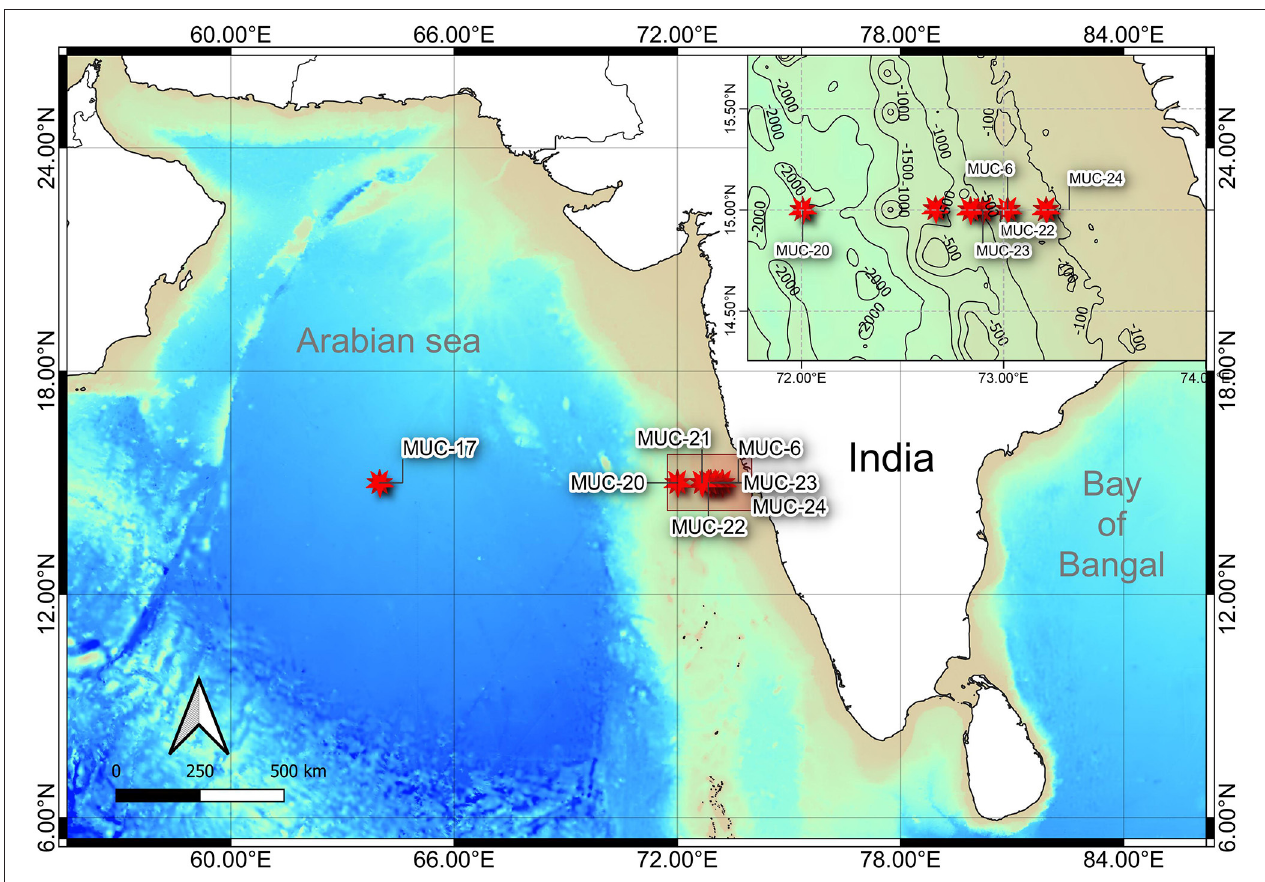
FIGURE 1 | Bathymetric map showing the sampling locations along the Western Indian Continental Margin (WICM) and in abyssal plain, Arabian Sea. Map data: GEBCO 2019 (access date: